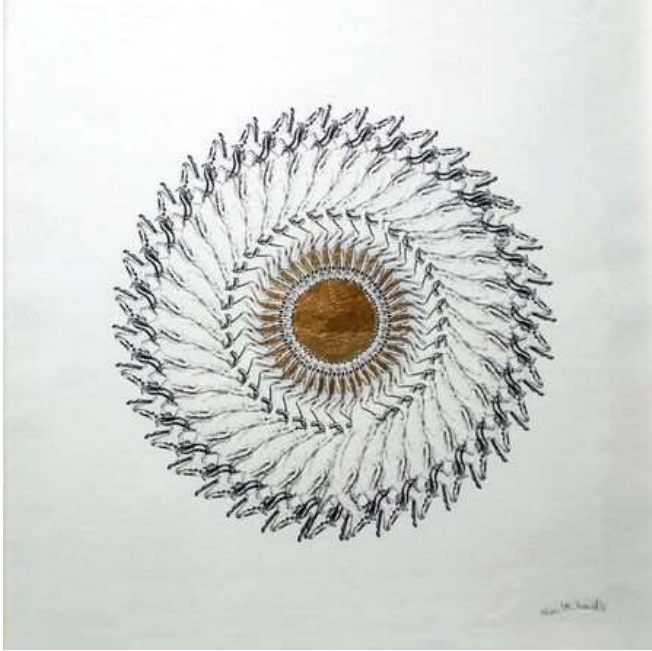
Figure 1. Manal Mahamid, Infinity , 2016 Etching & mixed media on archival paper 23 3/5 × 23 3/5 in 60 × 60 cm Edition 1/4 + 1AP.